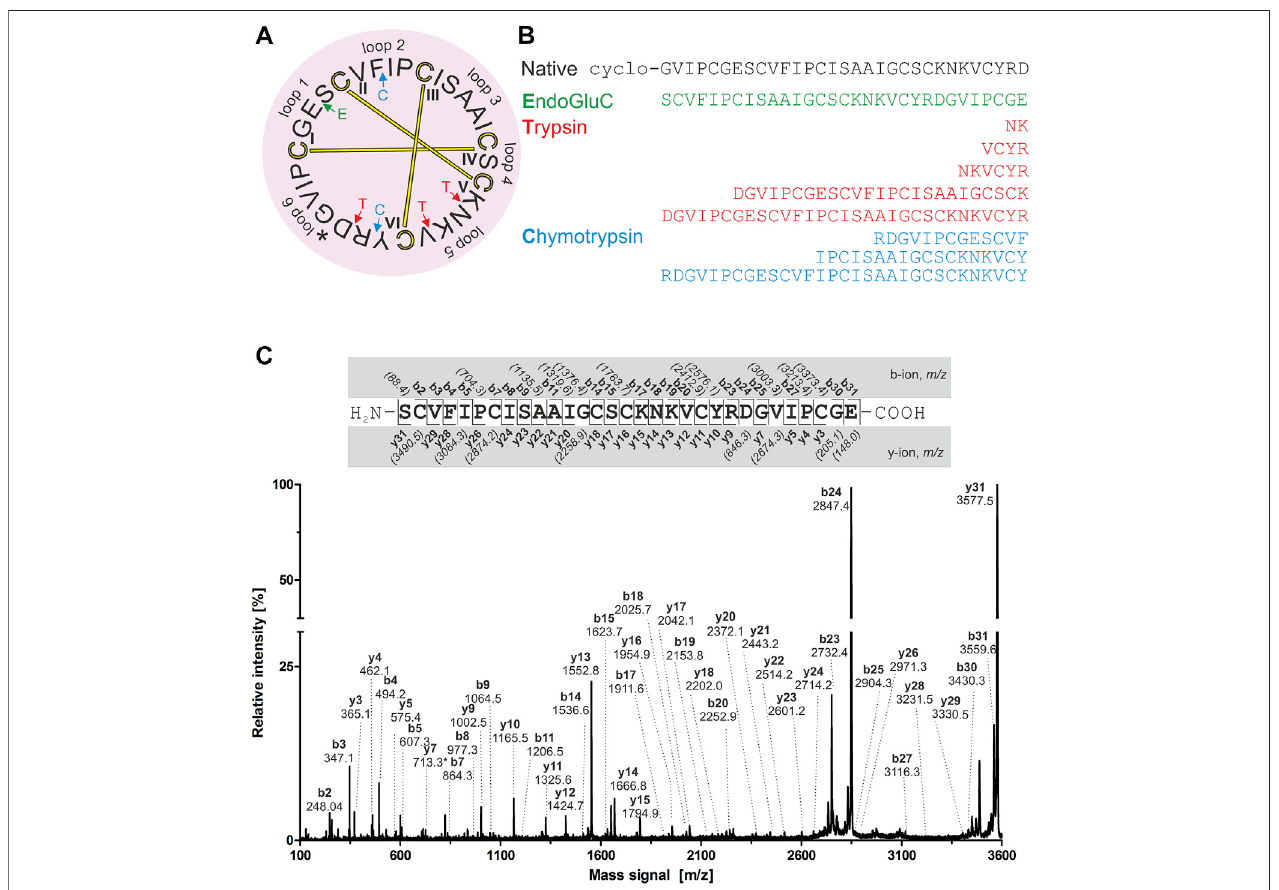
FIGURE5| Aminoacidsequenceanalysisofalca1.Isolatedalca1peptidewithnative m/z 3,211.4waspreparedformassspectrometricexperimentswithcollision induced fragmentation. The determined amino acid sequence is shown in a circular plot. The observed cleavage sites for endoprotease GluC (green), trypsin (red) and chymotrypsin (blue) are indicated with arrows. The cystine knot con fi guration was assumed by homology to cyclotides (cysteines are numbered and connected as follows: I-IV, II-V and III-VI) and disulphides are indicated with connecting bars in yellow. The intercysteine loops are numbered with 1, 2, 3 etc., starting with the nativeligationsite(indicatedwithanasterisk) (A) TheobservedpeptidefragmentsinMSanalysisaredenotedinoneletteraminoacidcode (B) .Theionfragmentspectra ofpeptideprecursor m/z 3,577.5derivedfrom proteolytic cleavage byendoprotease GluC ispresented including labelling ofall identi fi ed fragment ions. Thedetermined amino acid sequence is depicted on the top from N-to the C-terminus. The identi fi ed y- and b-ions are labelled ( e.g. y 1 , y 2 , etc.) and missing signals are italic numbers in brackets (C) .